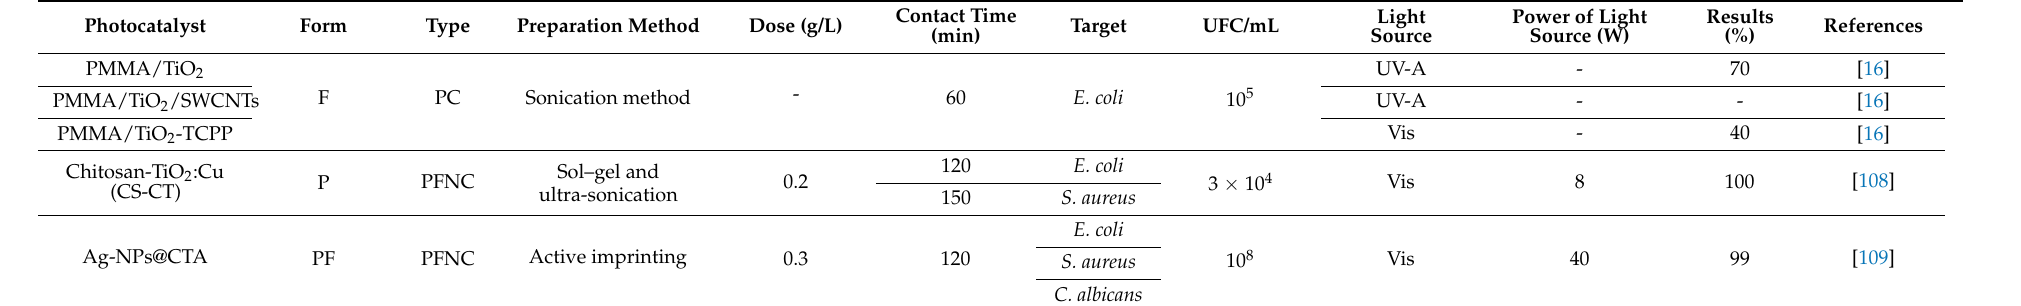
Table 3. Polymer based photocatalysts nanocomposite for microorganism